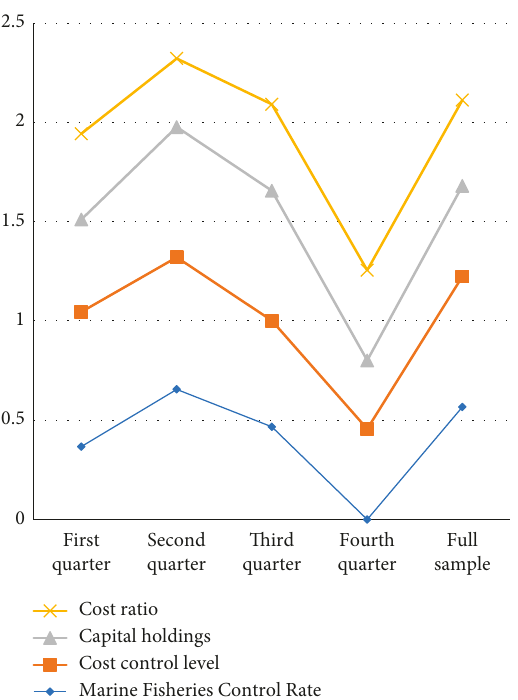
Figure 4: Cost dynamic control index